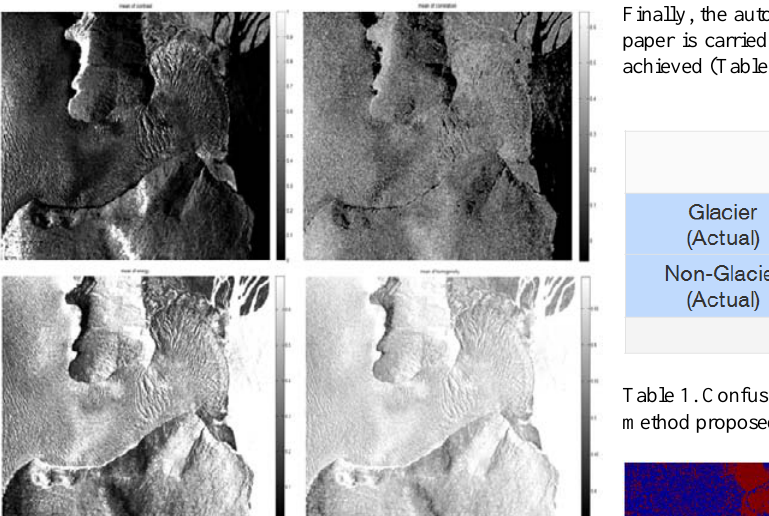
Figure 5. Upper left: mean value of contrast. Upper right: mean value of correlation. Lower left: mean value of energy. Lower right: mean value of homogeneity.